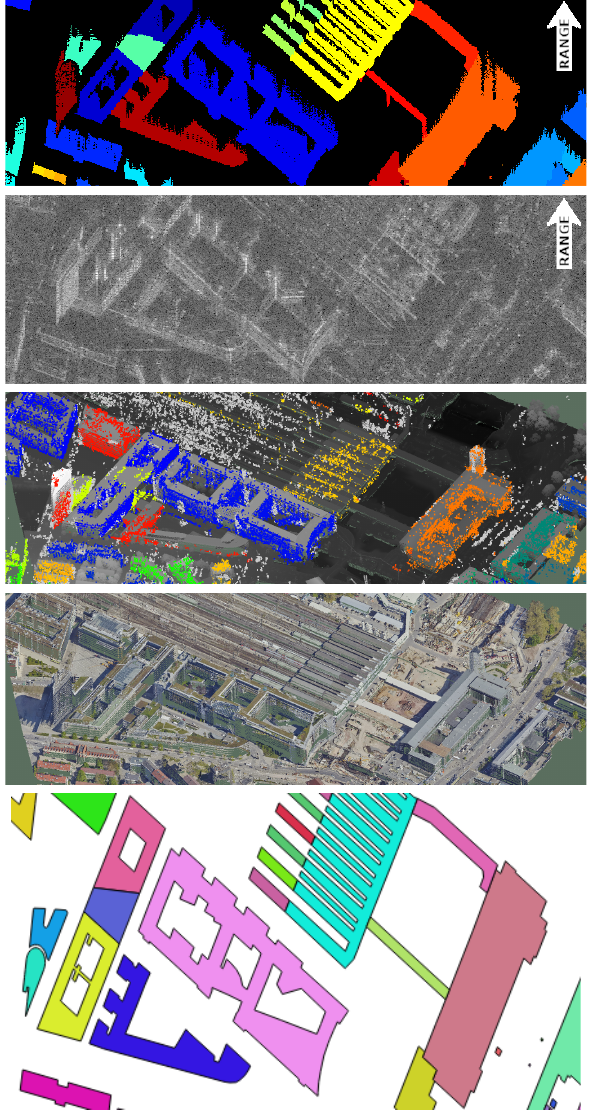
Figure 3. Result of Reverse Geocoding: from top to bottom: Building instances in slant-range geometry (SL); Amplitude SAR image in SL; 3d view of DSM with PS-points (one color per building); 3d view of RGB ALS point cloud; Building footprints from Open Street